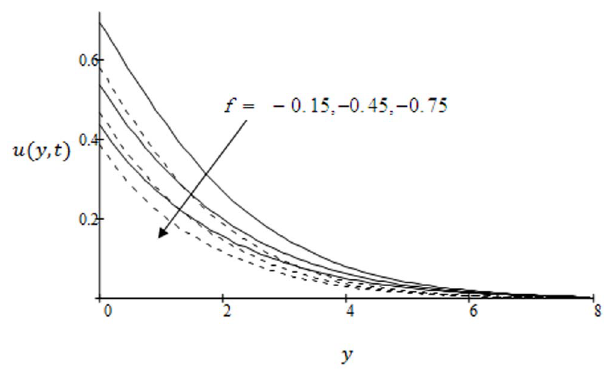
Figure 8. Velocity profiles for different values of constant shear stress f